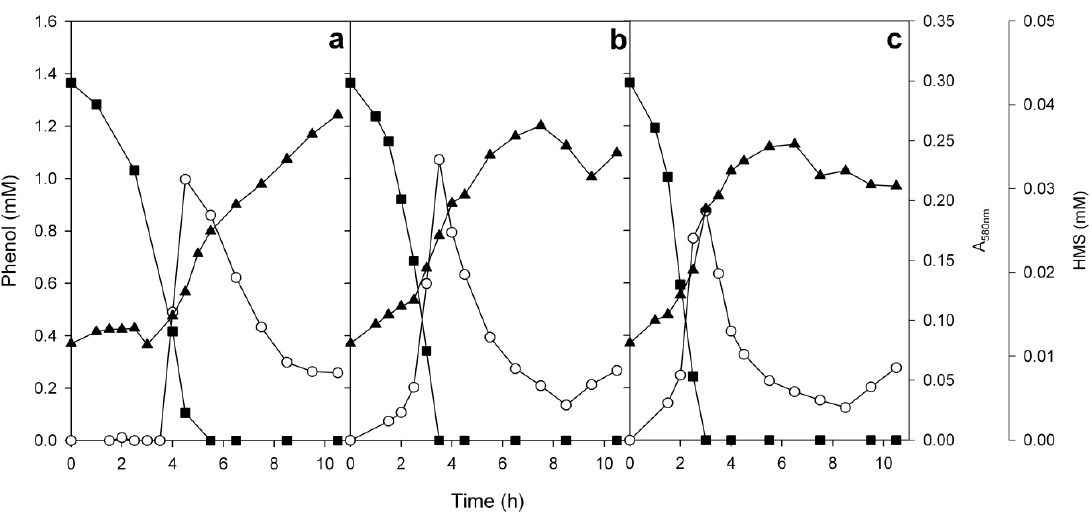
Figure 7. Growth of the strain ICTN13 on 1.3 mM phenol incubated at 25 ( a ), 30 ( b ), and 35 ( c ) °C. Growth ( ▲ , measured as absorbance at 580 nm), degradation of phenol ( ■ ) and accumulation of 2-hydroxymuconic semialdehyde (HMS, ○ ). Concentrations of the substrates and intermediates are the averages of triplicate determinations; the combined standard uncertainties of the results were between 2.1% and 3.4%.